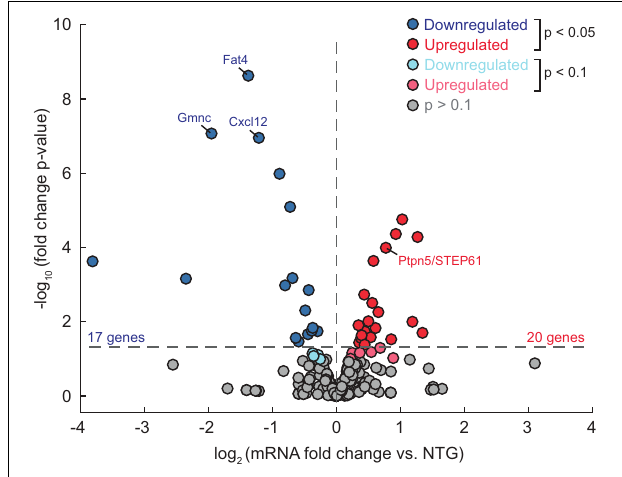
FIGURE 5 | Some (cid:49) FosB target genes bound in APP and Pilo mice are differentially expressed in the DG of APP mice (vs. NTG). RNA-seq was performed using dentate gyrus tissue from APP and NTG mice ( n = 4/genotype), and differential gene expression was assessed using DESeq. Volcano plot illustrates gene expression data of the subset of 442 target genes bound by (cid:49) FosB in both APP and Pilo mice. Horizontal dotted line indicates p < 0.05 threshold, while vertical dotted line separates upregulated genes from downregulated genes. Color of dot indicates significance level. Expression levels of labeled genes were independently assessed using RT-qPCR, as shown in Figure 6